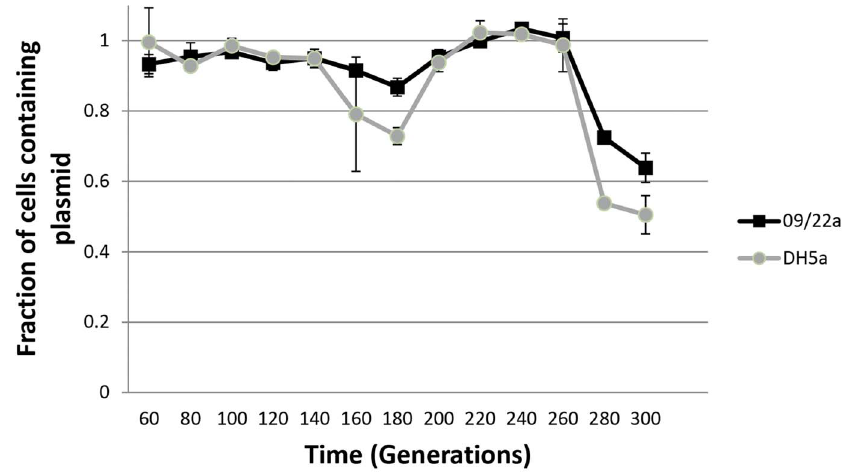
Figure 4. Stability of pEBG1 in the absence of selection in its natural host, 09/22a, and in laboratory strain DH5 a .